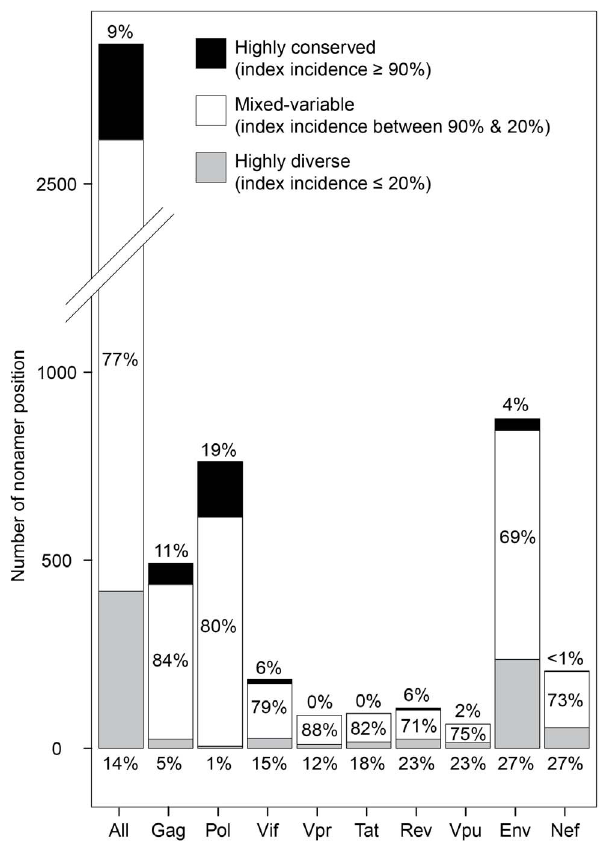
Figure 3. Distribution of conservation level of nonamer positions. The nonamer positions of the proteome and the individual proteins were defined as highly conserved (black, index incidence $ 90%), mixed-variable (white, index incidence , 90% & . 20%), and highly diverse (grey, index incidence # 20%). Highly conserved positions were only 9% of total proteome nonamer positions, ranging from 0% for Vpr and Tat, to 19% for Pol. Highly diverse positions comprised 14% of the proteome, ranging from 1% Pol to 27% Env and Nef, each. Mixed- variable positions comprised 77% of the proteome, ranging from 69% Env to 88%